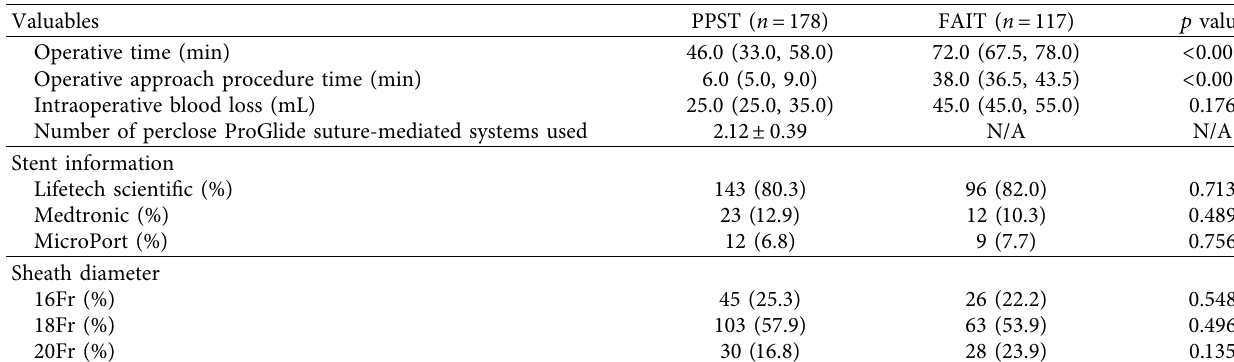
Table 2: Surgical data on the two patient groups.